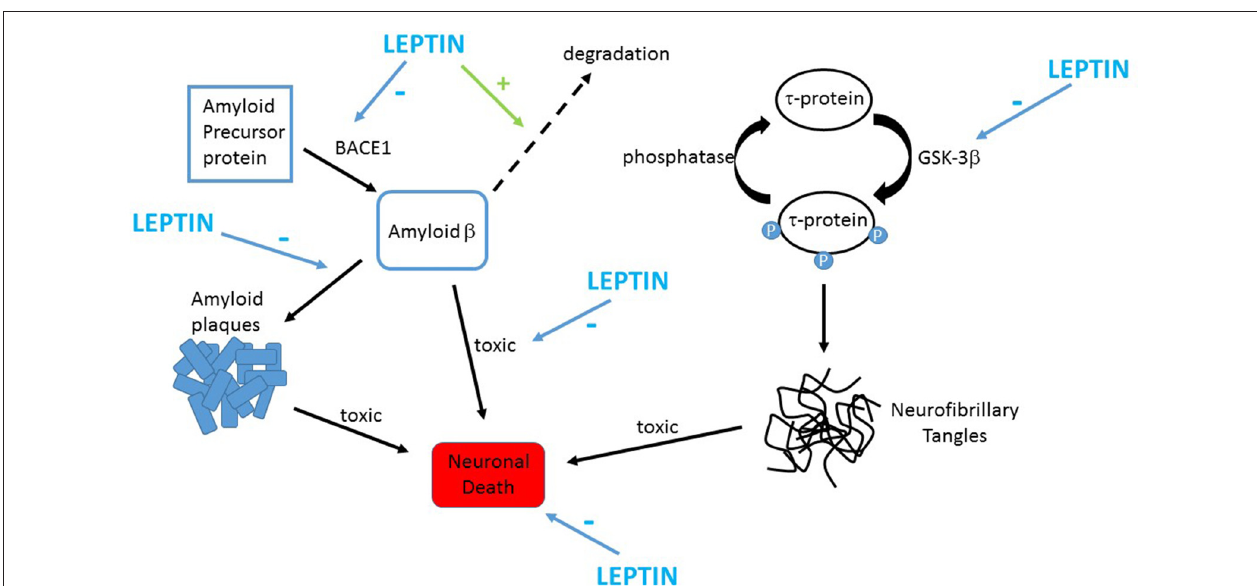
FIGURE 2 | Leptin prevents the key pathological changes in Alzheimer’s disease (AD). Schematic representation of the protective actions of leptin in AD. Toxic forms of A β are formed by the proteolytic processing of APP by the enzyme BACE1. Leptin limits production of A β in neurons via inhibiting BACE1 activity. Leptin also attenuates extracellular A β levels by promoting the clearance and degradation of A β . Accumulation of A β promotes assembly of fibrillary forms of A β that leads to formation amyloid plaques. Leptin reduces plaque formation by reducing expression of GM1 gangliosides thereby limiting assembly of fibrillary A β . Leptin also counteracts the harmful effects of A β as it protects against the toxic actions of A β via stimulation of pro-survival signaling pathways. Hyper-phosphorylation of tau protein occurs in AD which results in formation of neurofibrillary tangles. GSK-3 β drives phosphorylation of tau, and leptin limits this via inhibiting the activity of GSK-3 β